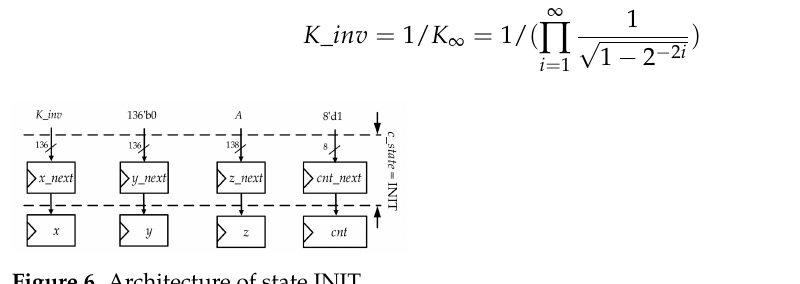
Figure 6. Architecture of state INIT. State ITE is to perform QH-CORDIC computation of exponential function e input_num .